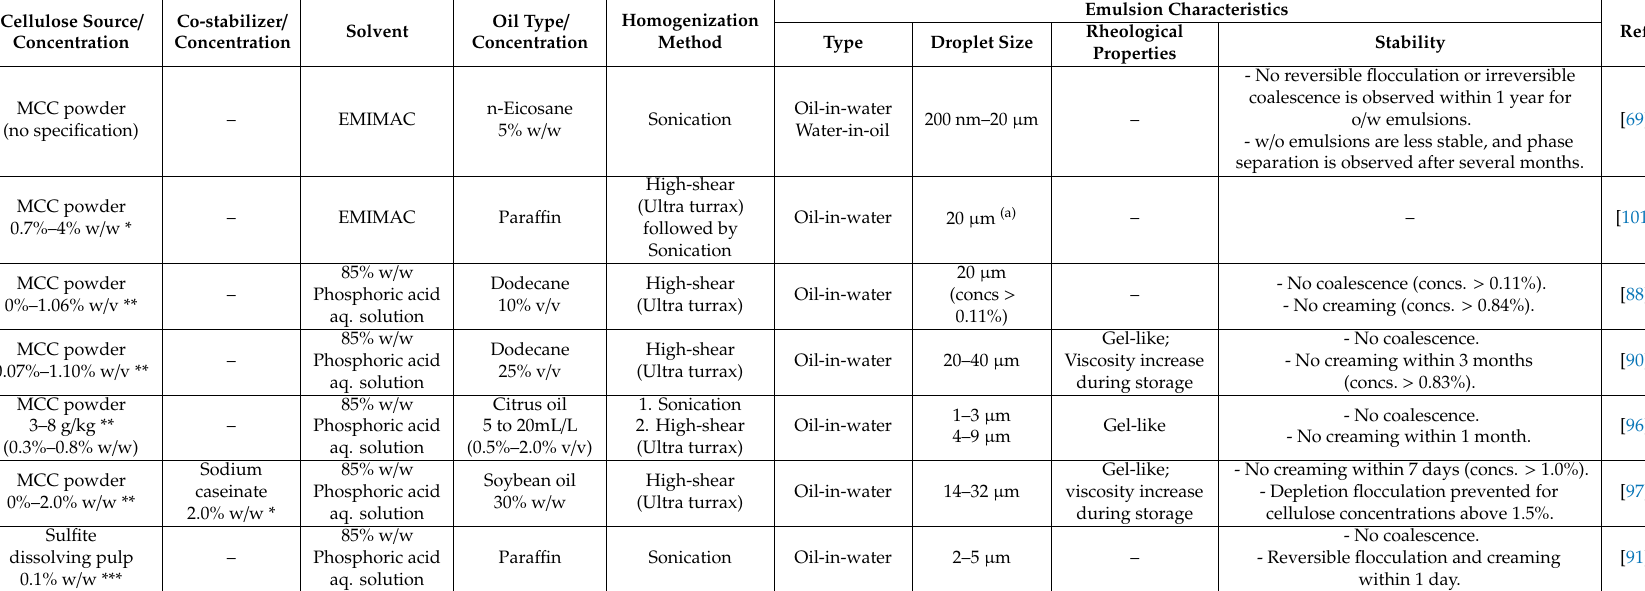
Table 1. Brief summary of the formulation and characteristics of emulsions stabilized by regenerated